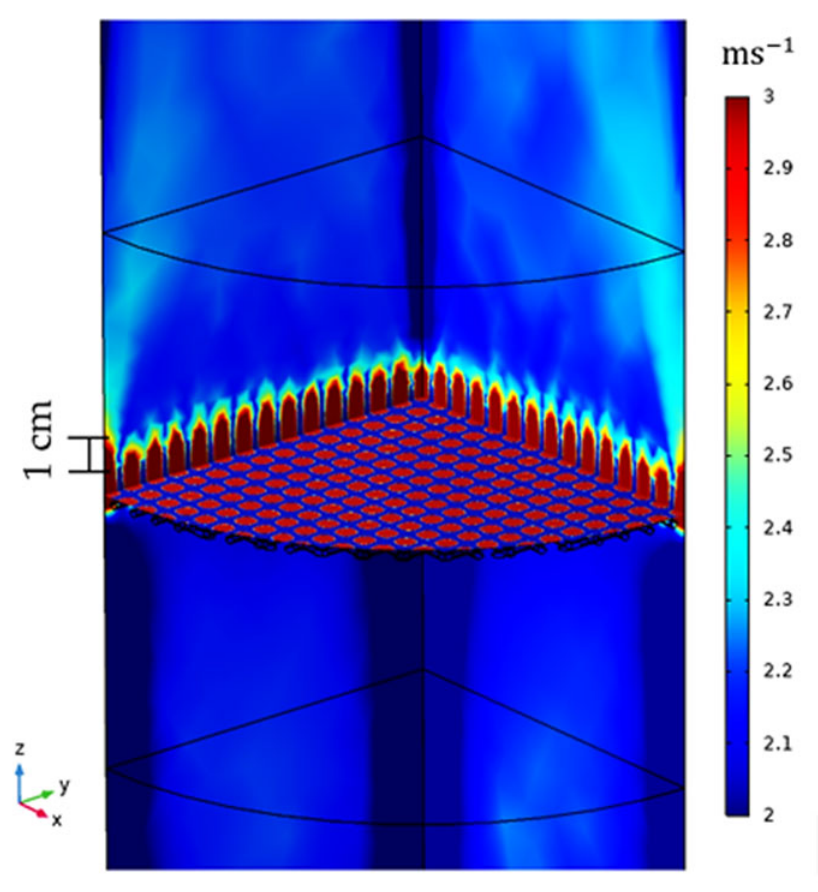
Figure 8. Examples of the gas velocity field for the nonheated unloaded microwave applicator using a 30 ppi foam and a gas flow in z -direction with an inlet velocity of u g = 2.5 ms − a 30 ppi foam and a gas flow in 𝑧 ‐ direction with an inlet velocity of 𝑢